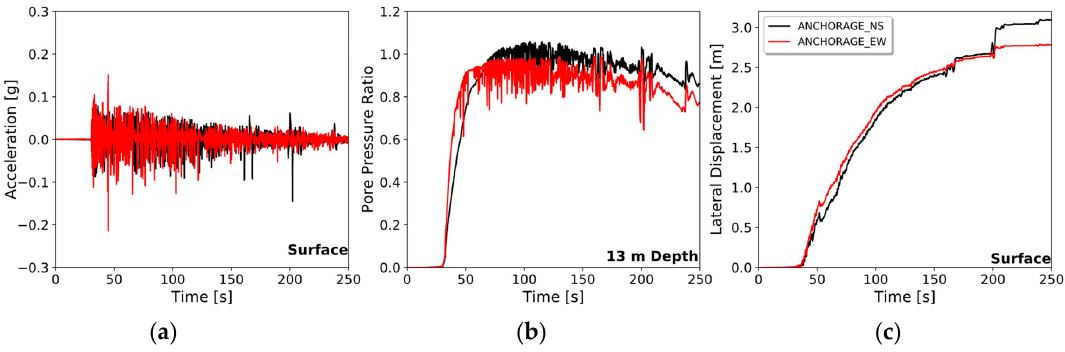
Figure 19. Numerical modeling results using both simulated horizontal motions in Anchorage. ( a ) horizontal acceleration at the surface, ( b ) excess pressure pore ratio at a 13 m depth, and ( c ) lateral displacement at the surface.